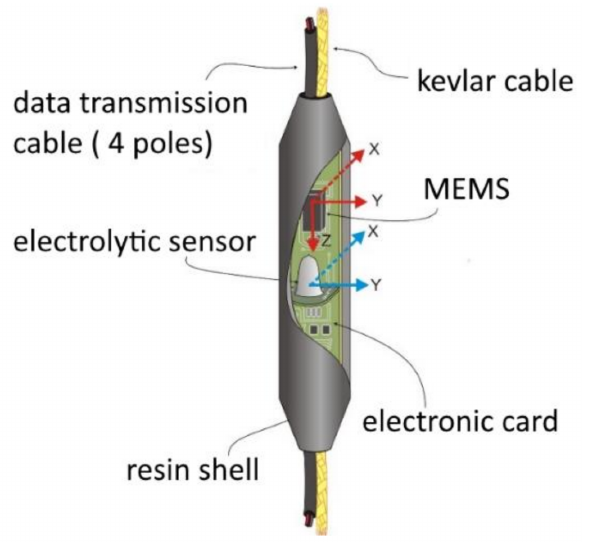
Figure 5. Tilt Link HR 3D sensor, equipped with 3D microelectromechanical system (MEMS) and 2D electrolytic cell, placed on the same electronic board, with instrumental axes aligned on the horizontal